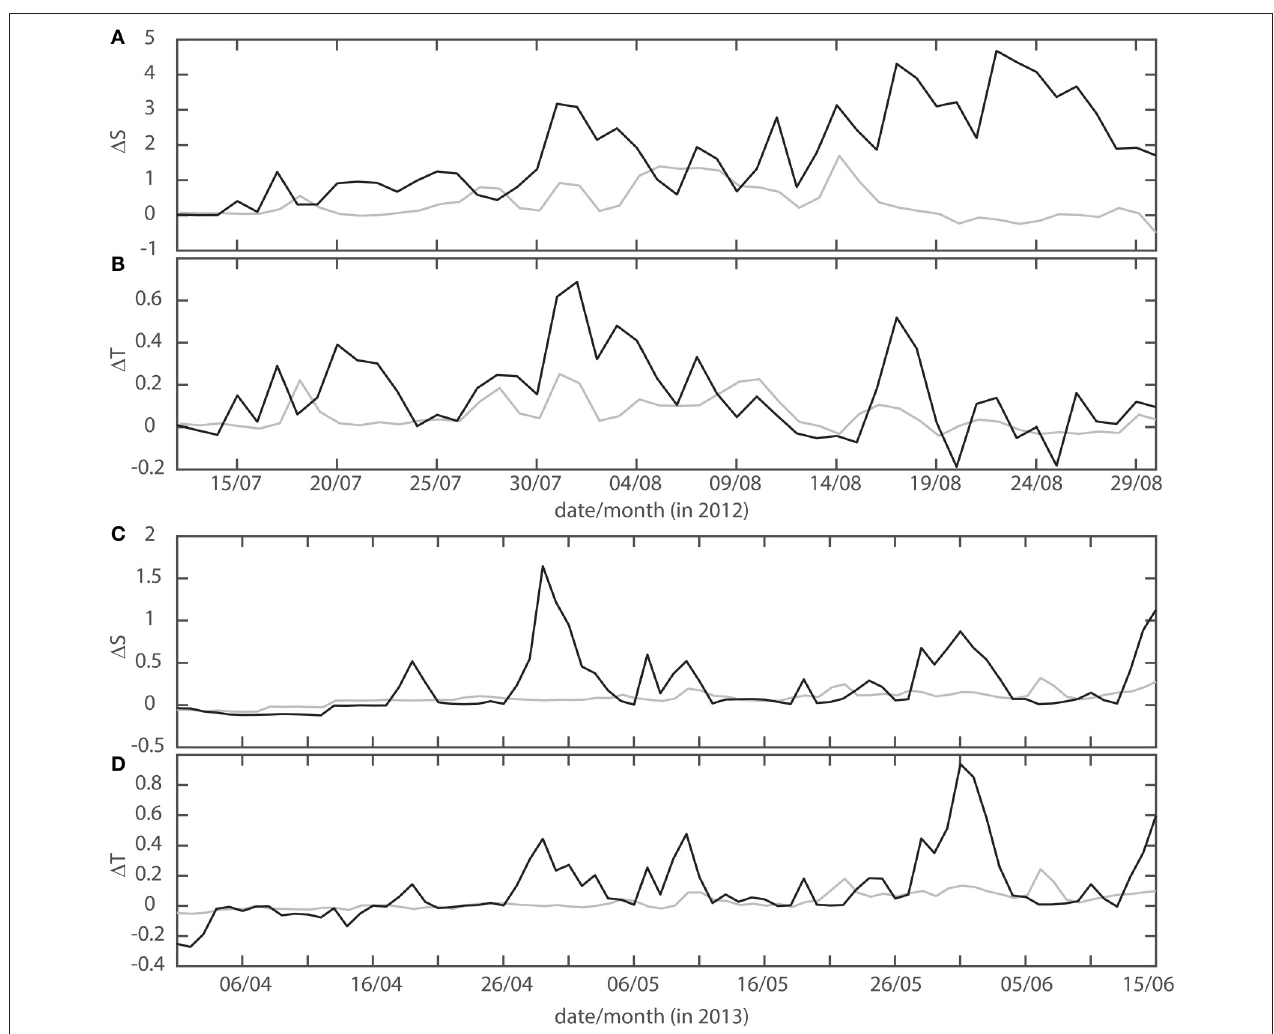
FIGURE 3 | Time series of salinity and temperature gradients over the upper 5 m for July to August 2012 (A,B) and April to June 2013 (C,D) . WilsonB and Waiheke are black and gray lines,